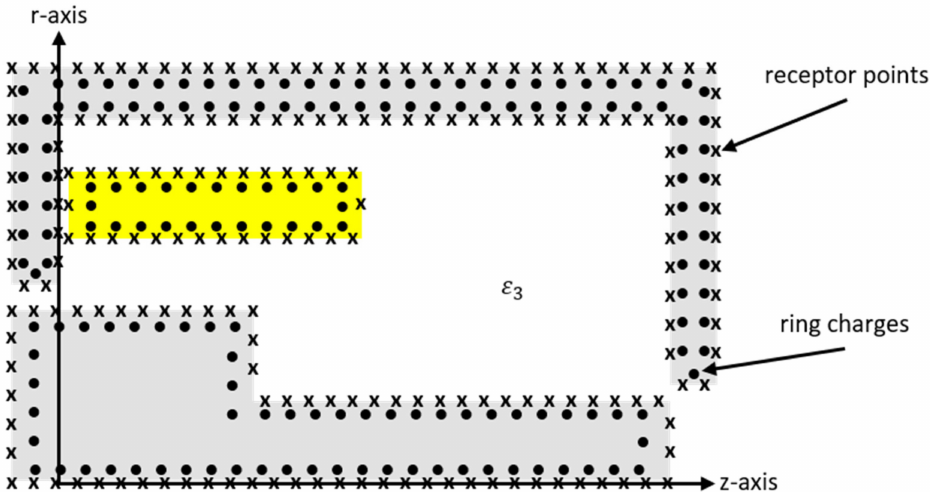
Figure 6. Representation of the electrodes in the end-winding